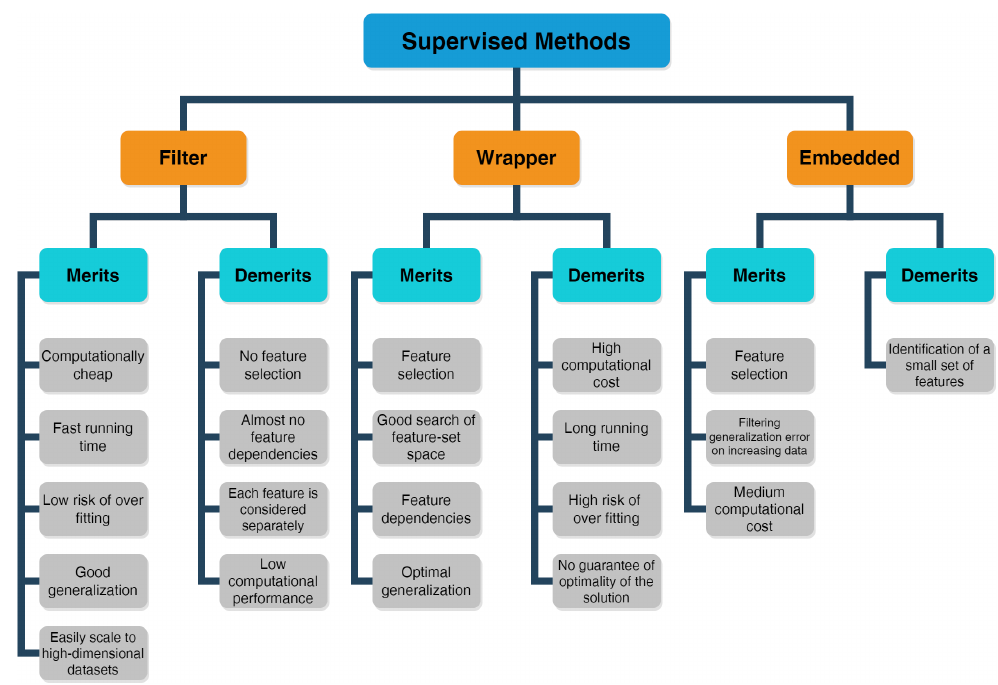
Figure 5. Scheme about merits and demerits of supervised methods, including filter, wrapper and embedded feature selection